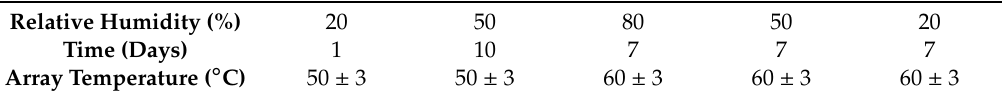
Table 2. Climatic chamber settings and measured temperature by the